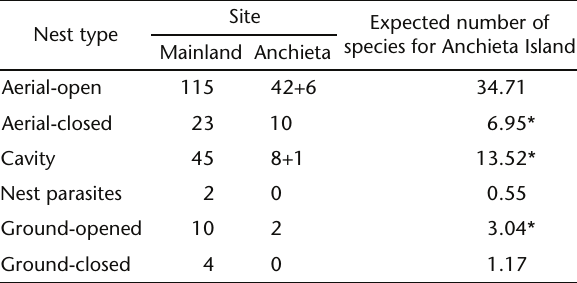
Table III. Bird species grouped by their nest habitats on the mainland of Serra do Mar (Caraguatatuba) and Anchieta Island. The actual number of species in Anchieta is the sum of two numbers, respectively, the number of species that also occurs in Caraguatatuba (N = 60) and the number of species that only occur in Anchieta (N = 7). The expected number of species is the mean predicted by our null model (see text for further details). * p <